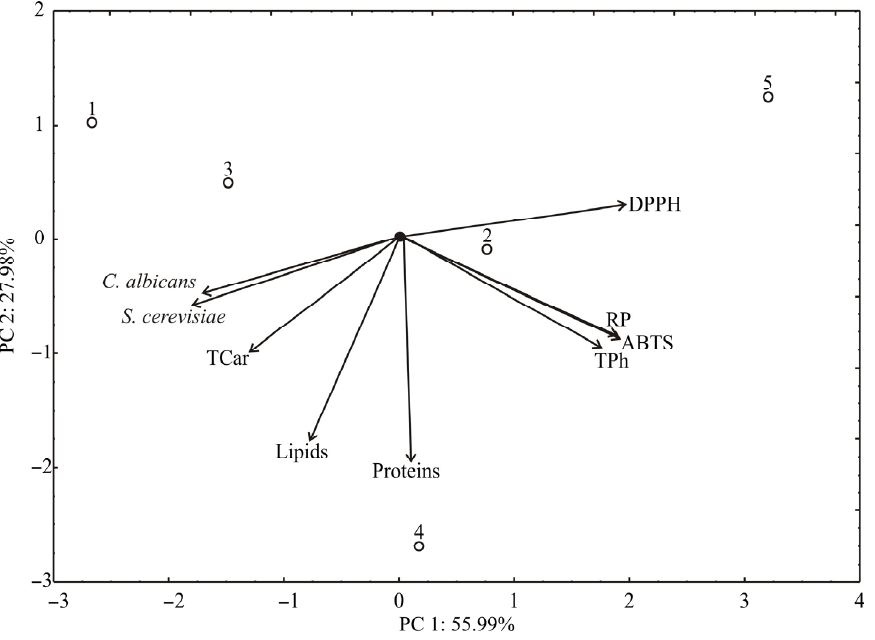
Figure 4. PCA ordination of variables based on correlations of seed samples .